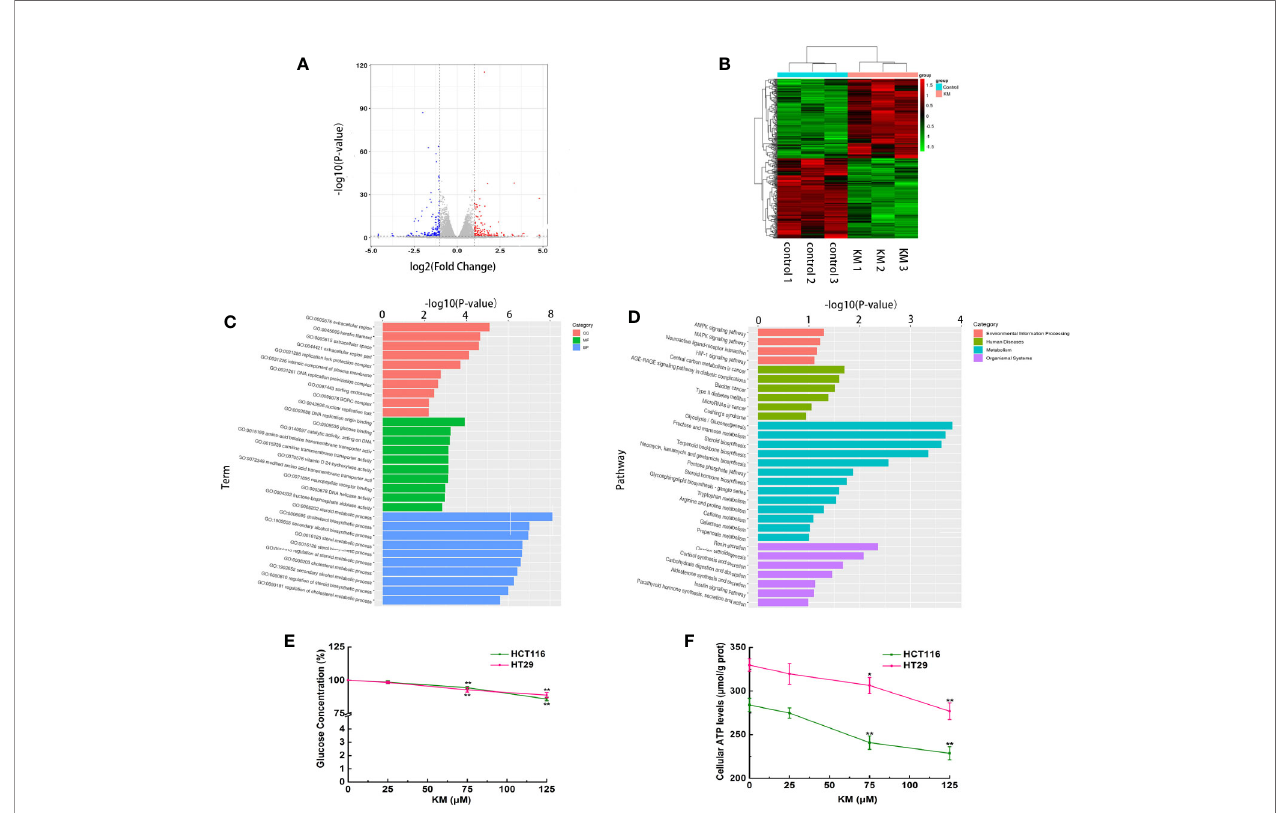
FIGURE 4 | (A) Volcano plot of the DEGs with FDR ≤ 0.05 and the fold change ≥ 2. Red dots indicate upregulated DEGs; blue ones indicate downregulated DEGs, and gray ones indicate no signi fi cant difference. (B) Heatmap of expression pro fi le for the 306 DEGs (153 upregulated and 153 downregulated). Each row represents a mRNA and each column represents a sample. (C) Gene ontology (GO) enrichment analysis of DEGs. (D) Kyoto Encyclopedia of Genes and Genomes (KEGG) pathway enrichment analysis of DEGs. (E) Effect of KM on glucose consumption. (F) Effect of KM on production of cellular ATP. Data were presented as mean ± SD (n = 3); signi fi cance: * P < 0.05, ** P < 0.01 vs